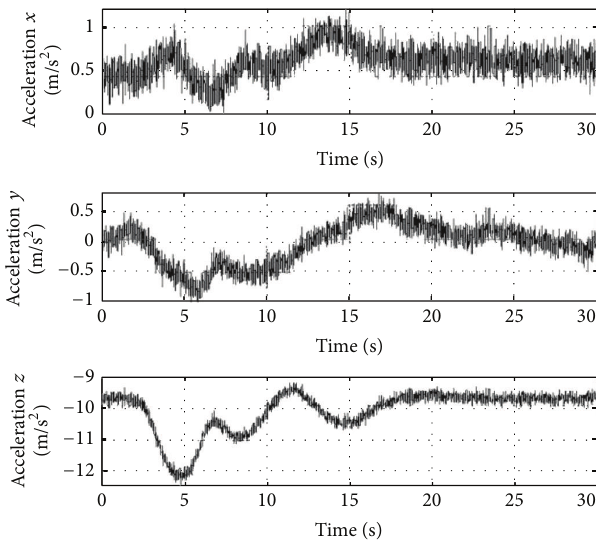
Figure 18: Accelerations measured.